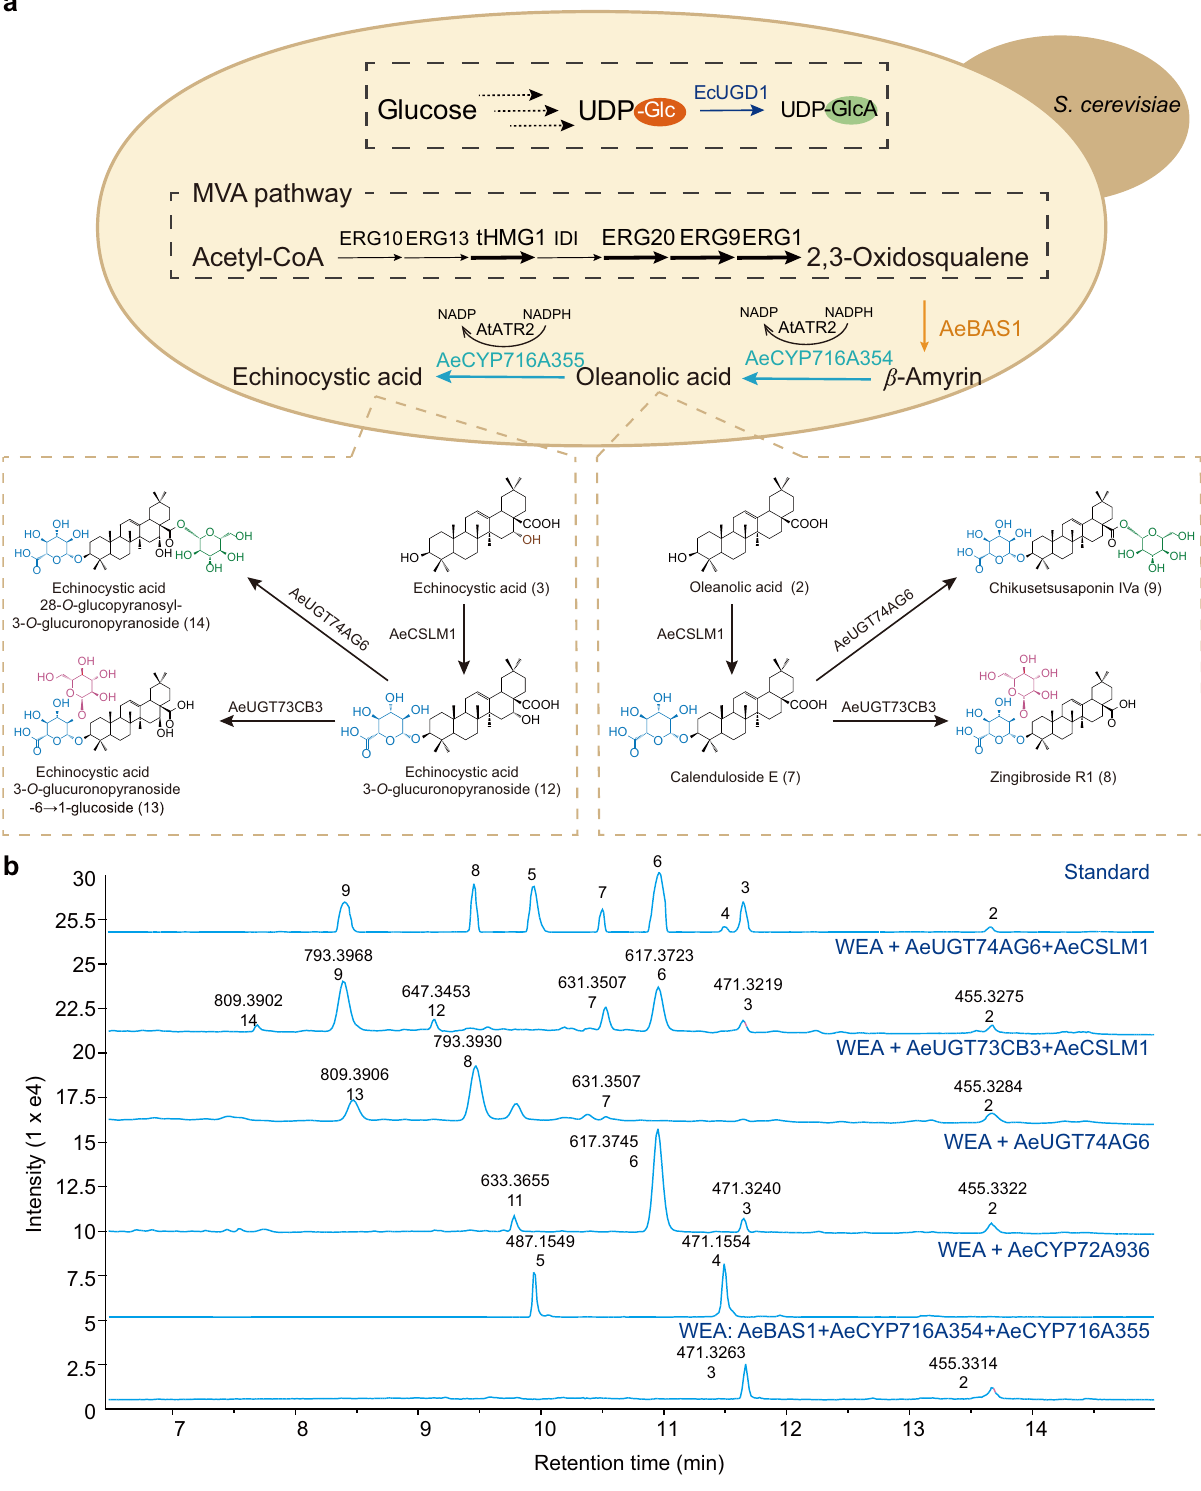
Fig. 6 De novo biosynthesis of oleanane-type pentacyclic triterpenes in yeast. a The strain WEA expressed AeBAS , AeCYP716A354 , and AeCYP716A355 and overexpressed the MVA and early sterol-pathway genes tHMG1 , ERG20 , ERG9, and ERG1 . Diagram showing the echinocystic acid-type triterpenoid biosynthetic pathway. b LC – MS analysis of metabolites from strains engineered for pentacyclic triterpene saponin production derived from β -amyrin and oleanolic acid. Extracted ion chromatograms using m/z values (±0.5) and different numbers to represent saponins with various aralosides, oleanolic acid ( m/z 455, 2), echinocystic acid ( m/z 471, 3), hederagenin ( m/z 471, 4), 16-OH-hederagenin ( m/z 487, 5), oleanolic acid 28- O -glucopyranosyl ester ( m / z 617, 6), calenduloside E ( m / z 631, 7), zingibroside R1 ( m/z 793, 8), chikusetsusaponin IVa ( m/z 793, 9), echinocystic acid 28- O -glucopyranosyl ester ( m/z 633, 11), 3- O -glucuronopyranoside echinocystic acid ( m/z 647, 12), echinocystic acid 28- O -glucopyranosyl-3- O -glucuronopyranoside ( m/z 809, 14), and echinocystic acid 3- O -glucuronopyranoside-6 → 1-glucoside ( m/z 809,